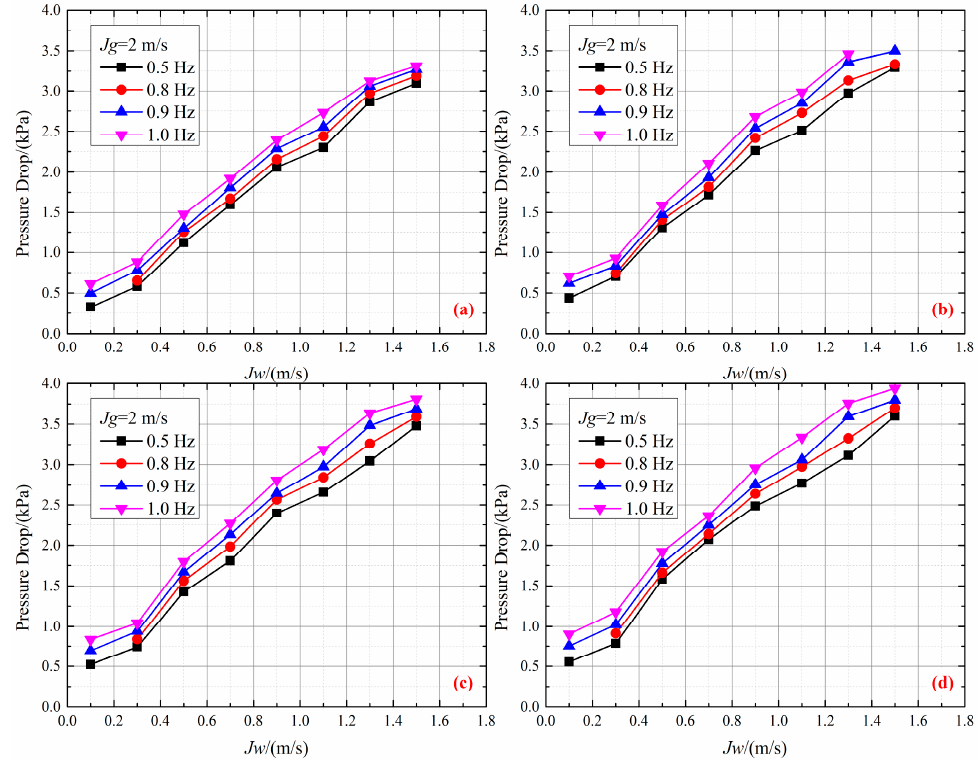
Figure 10. The effect of frequency on Δ P f : ( a ) A = 62 mm, ( b ) A = 80 mm, ( c ) A = 106 mm, ( d ) A = 120 mm.